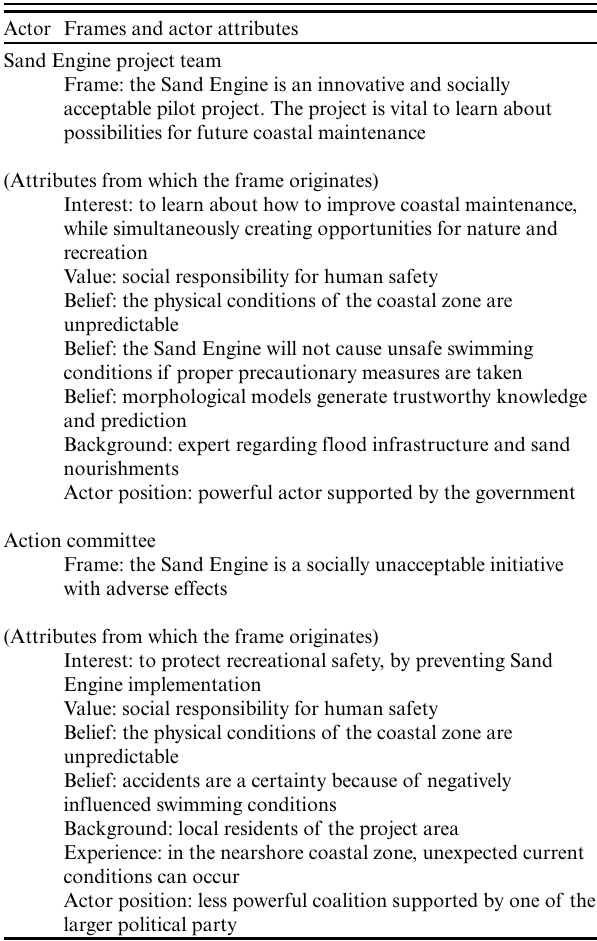
Table 2 . Sand Engine ambiguity 1: about the effects on swimmer